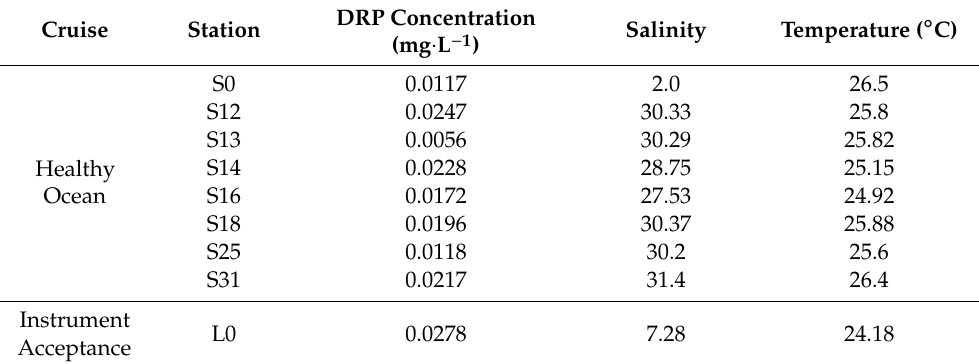
Figure 6. ( A ) In situ measurement results of the “Healthy Ocean” cruise and corresponding CTD data during underwater experiments; ( B ) in situ measurement results of the “Instrument Acceptance” cruise and corresponding CTD data during underwater experiments. Table 2. Online measurement results of the “Healthy Ocean” and “Instrument Acceptance” cruises.